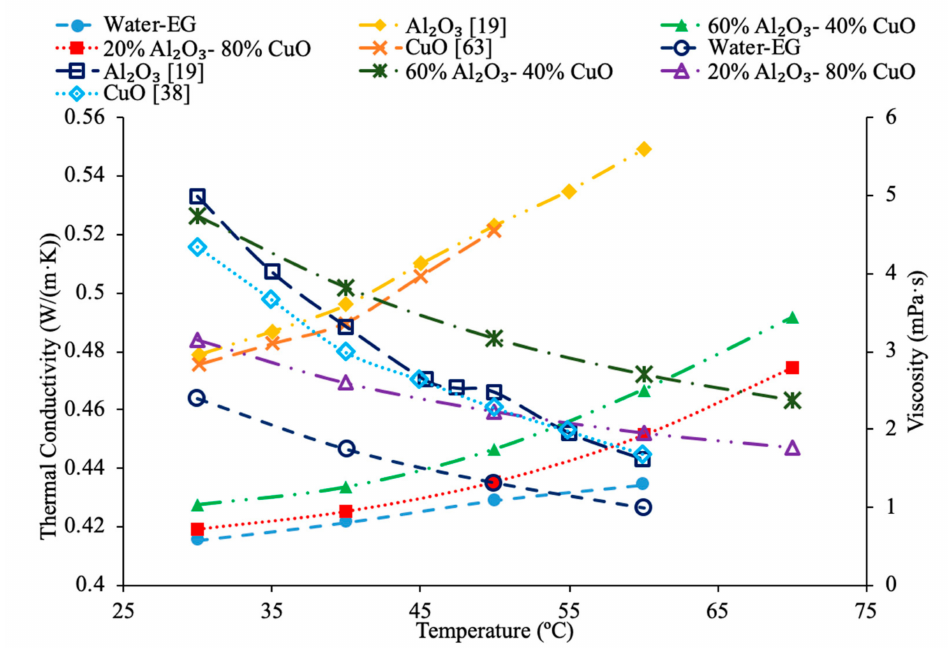
Figure 35. Thermal conductivity (increasing with temperature) and viscosity (decreasing with temperature) for Al 2 O 3 –CuO nanofluid at different ratios of Al 2 O 3 to CuO [74] compared to Al 2 O 3 and CuO nanofluids all in a base fluid of 40% ethylene glycol (EG)-60% water at volume fraction of 1%